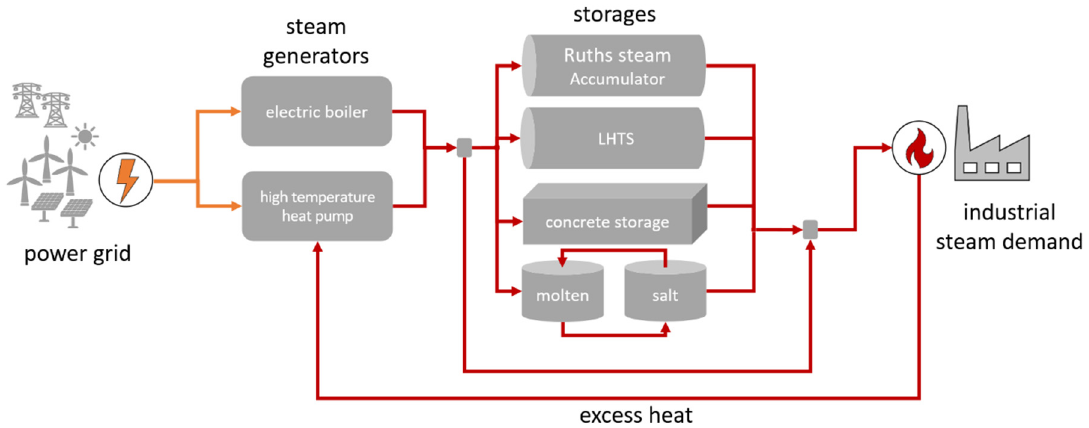
Figure 1. Schematic of the electricity-driven steam supply system considered within this work, showing the nodes and connectors considered in the